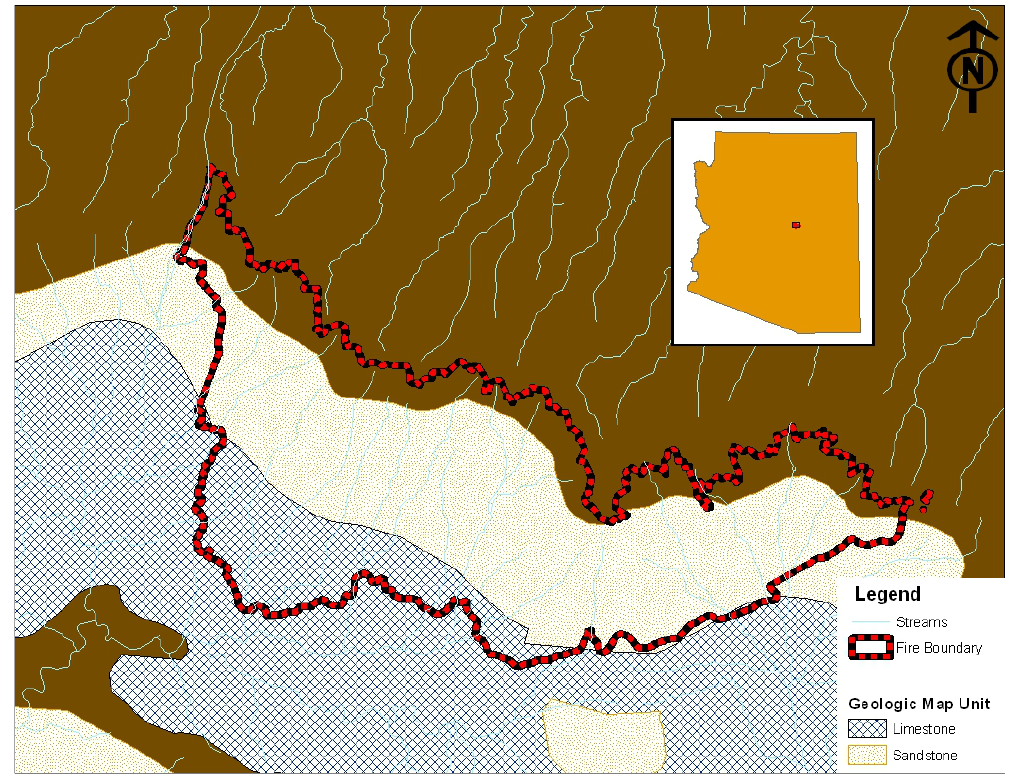
Figure 1. Boundary of the Dude Fire, Tonto National Forest, overlaying the geologic map of the area. The fire burned primarily over limestone and sandstone parent